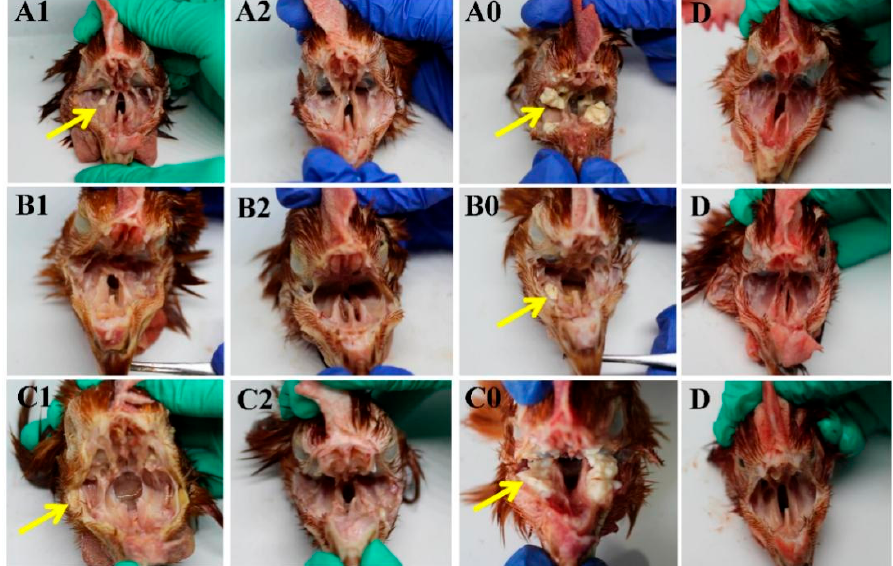
Figure 4. Gross lesions of the infraorbital sinus after challenge with Av. paragallinarum . The letters in the figure correspond to the groups. Yellow exudate clot (yellow arrows) was observed in the infraorbital sinus of chickens in groups A1, A0, B0, C1, and C0.